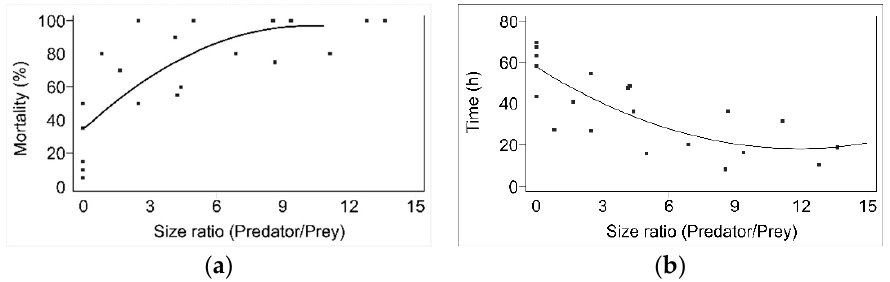
Figure A1. Relationship between mortality (%) ( a ) and survival time (h) ( b ) of Nabis pseudoferus as a function of the size ratio between cannibal and prey.